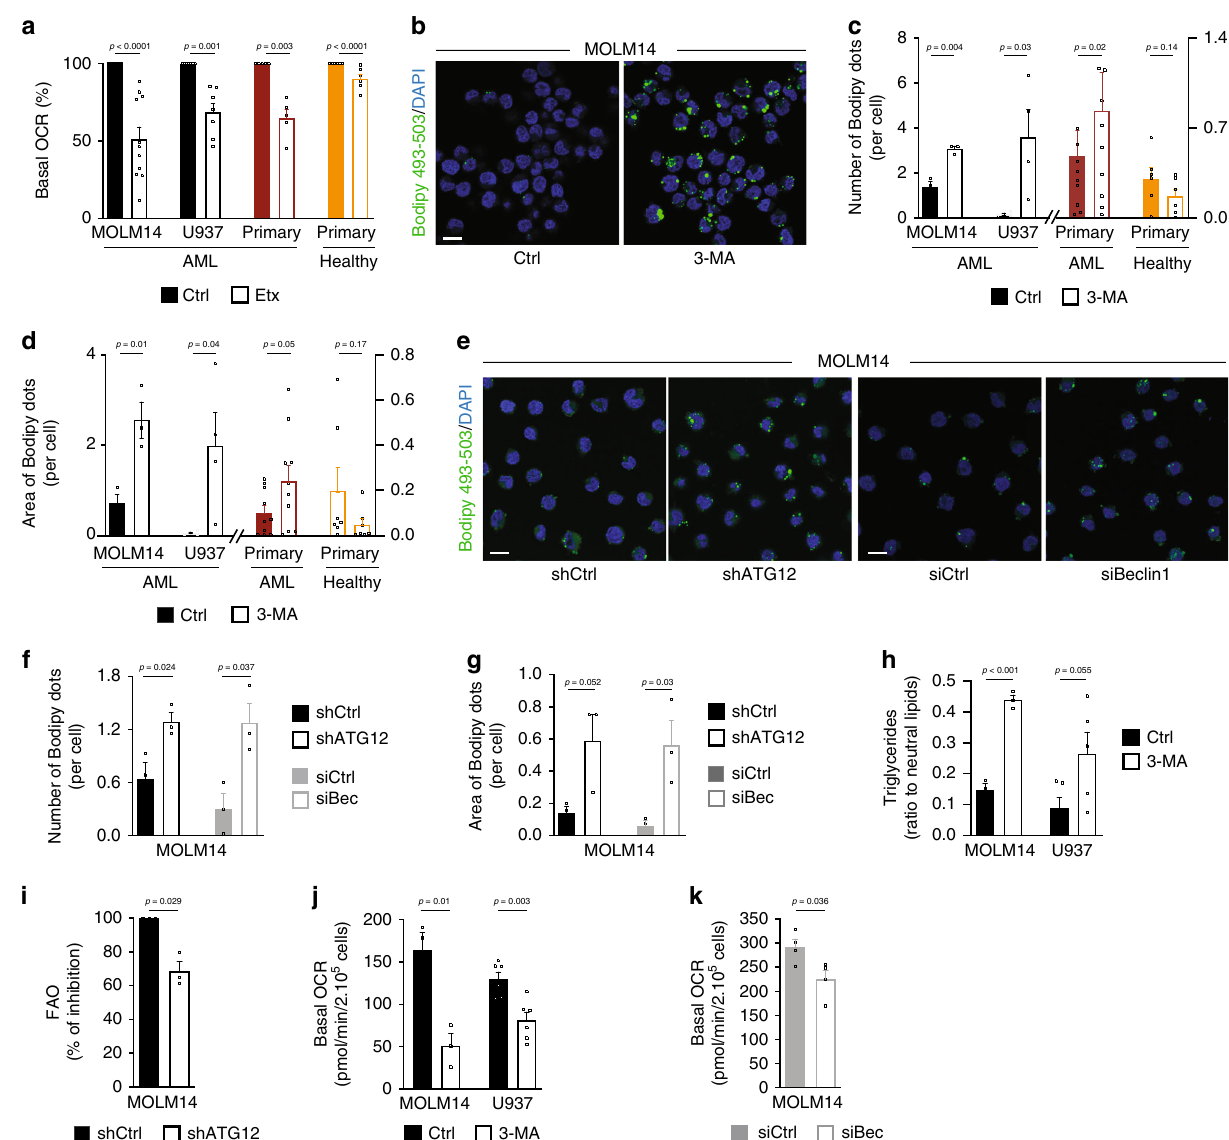
Fig. 1 Autophagy participates to lipid catabolism to support OxPHOS. a Seahorse measurement of basal oxygen consumption rate (OCR) in MOLM14 ( n = 11) and U937 ( n = 7) AML cell lines, in primary AML patient cells ( n = 4) and in primary normal hematopoietic cells (PBMC n = 6; CD34 + n = 3) treated or not with Etx (3 µ M, 15 min; one-sample t -test). b MOLM14 cells were treated with 3-methyladenine (3-MA, 5 mM, 24 h), fi xed and stained for Bodipy 493/503 and DAPI. Representative confocal pictures from three independent experiments are shown. Scale bar: 10 µ m. c , d MOLM14 ( n = 3) and U937 ( n = 4) AML cell lines, primary AML patient cells ( n = 10) and primary normal hematopoietic cells (PBMC n = 7) were treated or not with 3-MA (5 mM, 24 h), fi xed, and stained for Bodipy 493/503 and DAPI. Histograms show the number ( c ) or the area ( d ) of Bodipy 493/503 dots per cell (one- sample t -test). e , g MOLM14 cells were either transduced with a shRNA directed against ATG12 or transfected with a siRNA targeting Beclin1. Cells were then stained for Bodipy 493/503 and DAPI. Representative confocal pictures from three independent experiments are shown ( e ). Scale bar: 10 µ m. Graphs represent the number ( f ) or the area ( g ) of Bodipy 493/503 dots per cell, ( n = 3, unpaired t -test). h MOLM14 ( n = 3) and U937 ( n = 5) cells were treated with 3-MA (5 mM, 24 h), and processed for triglycerides content analysis. Graph represents the ratio of triglycerides on total neutral lipids (unpaired t -test). i MOLM14 transduced with Ctrl or ATG12 shRNAs were examined for their rates of β -oxidation, ( n = 3, one-sample t -test). j , k Seahorse measurement of basal OCR in MOLM14 ( n = 3) and U937 ( n = 6) cells treated or not with 3-MA for 24 h ( j ), or MOLM14 cells transfected with siRNA control or targeting Beclin1 ( n = 4) ( k ) (unpaired t -test). Data are means±